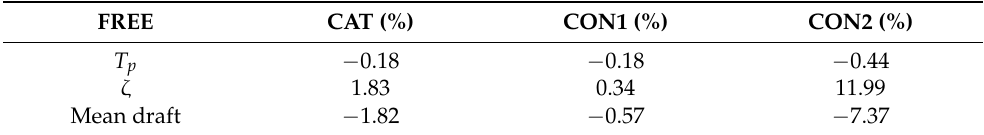
Table 8. Comparative changes of each system’s natural period, T p , of the percentage of critical damping, ζ , and the mean draft caused by the presence of the mooring systems obtained from decay tests in heave.